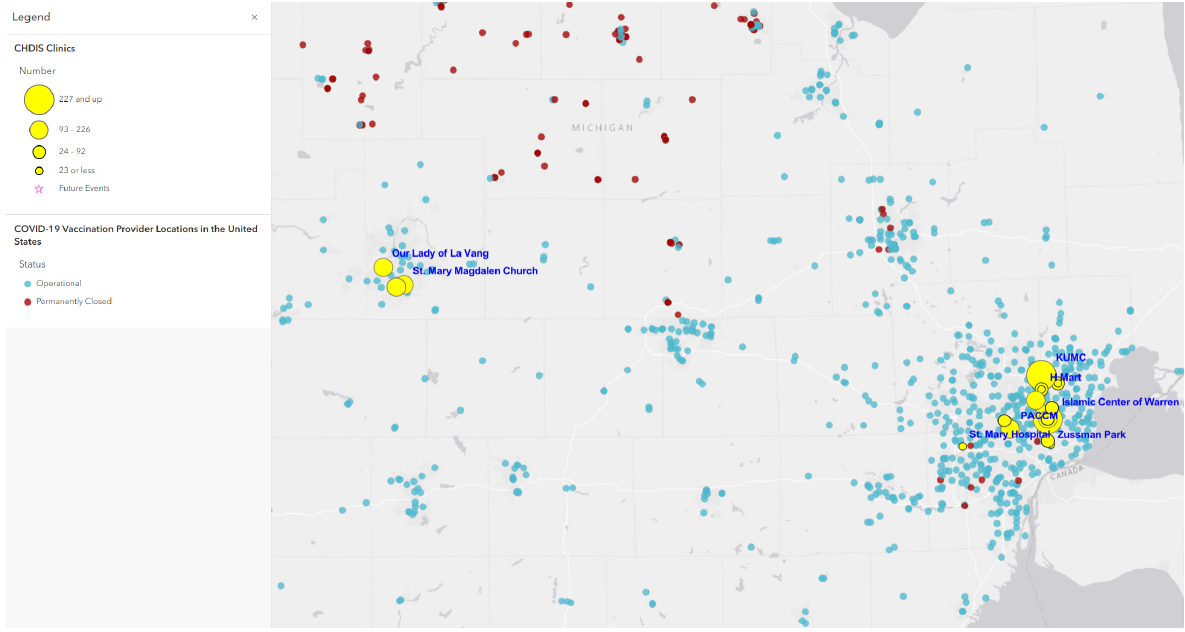
Figure 1. EMU CHDIS mobile clinics vs. COVID-19 vaccination provider locations.